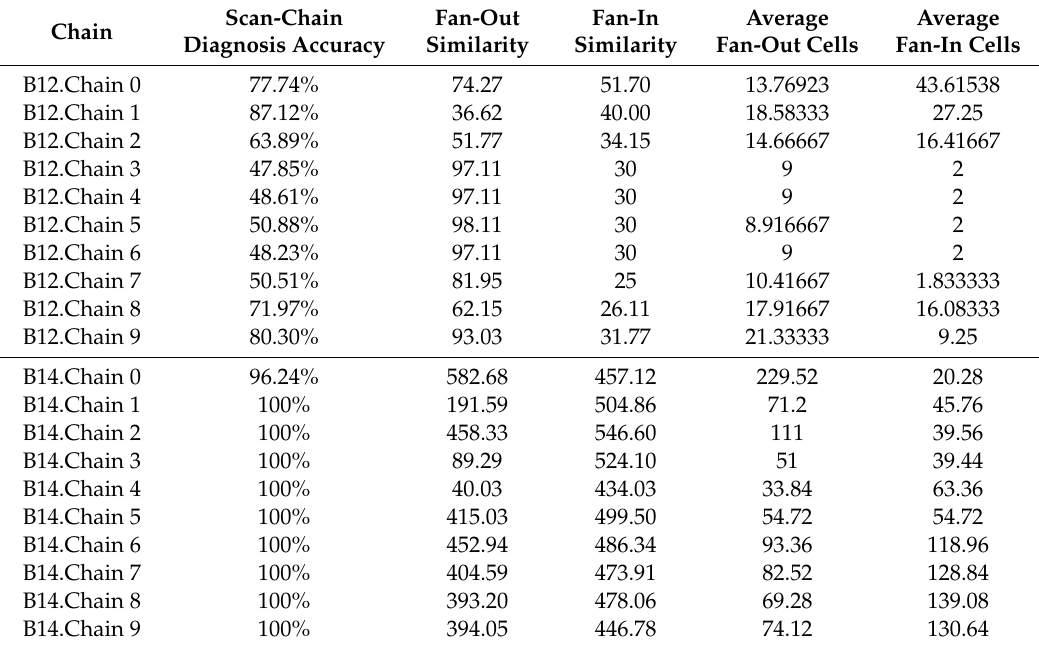
Table 9. Accuracy of scan-chain diagnosis for SA0 faults with the fan-out similarity, fan-in similarity, average fan-out cells, and average fan-in